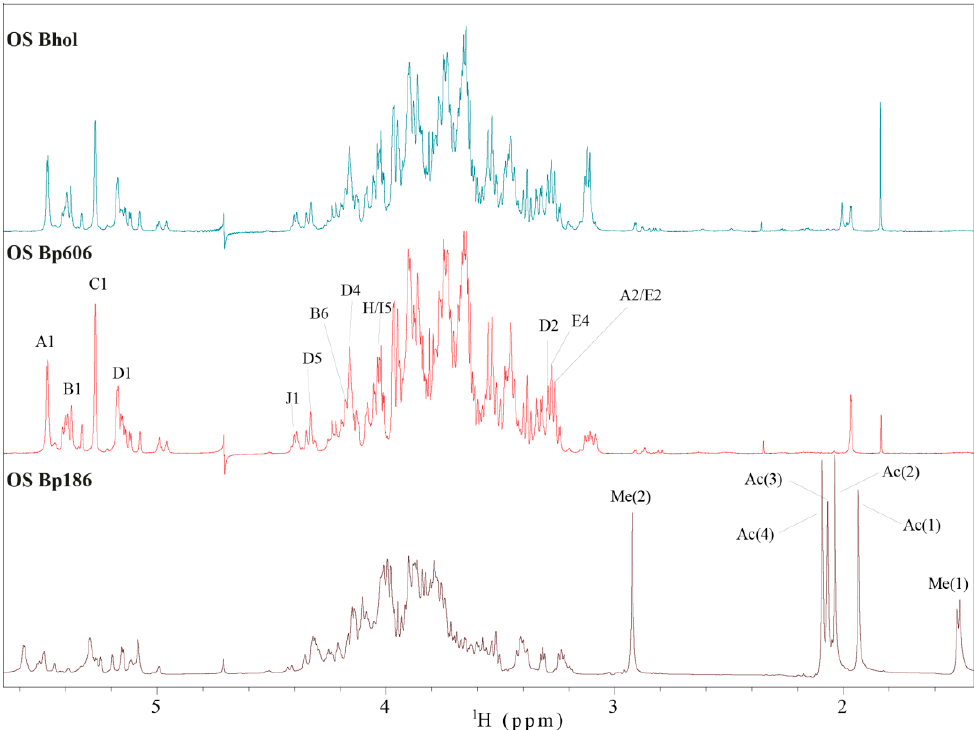
Figure 8. Structure reporter groups in the 1 H NMR spectra of the oligosaccharides of B. pertussis (strains 186 and 606) and B. holmesii ATCC 51541. The capital letters refer to carbohydrate residues as shown on the structure, and the numbers refer to protons in respective residues. The resonances marked with Me(1), N-methyl, Me(2), exocyclic CH 3 and Ac(4), N-acetyl of L -Fuc p 2NAc4NMe, Ac(1) and Ac(3), N-acetyls of Man p 2NAc3NAcA and Ac(2), N-acetyl of Glc p NAc indicate the distal [ α - D -Glc p NAc-(1 → 4)- β - D -Man p 2NAc3NAcA-(1 → 3)- β - L -Fuc p 2NAc4NMe-(1 → ] trisaccharide in the structure of B. pertussis 186 LOS.